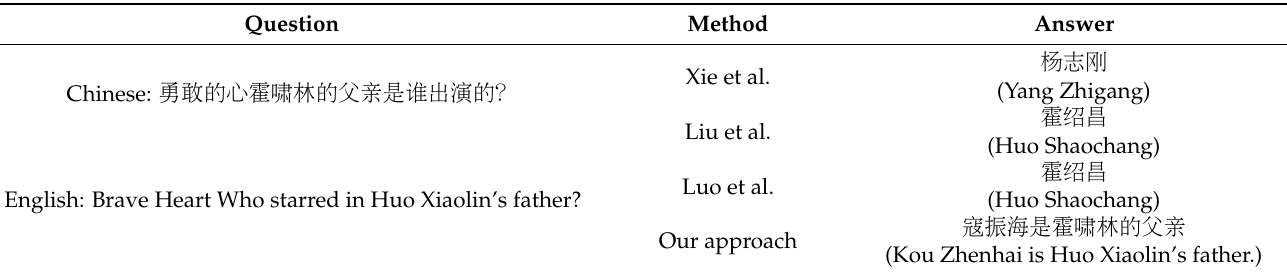
Table 7. Example of the answer returned by the experimental